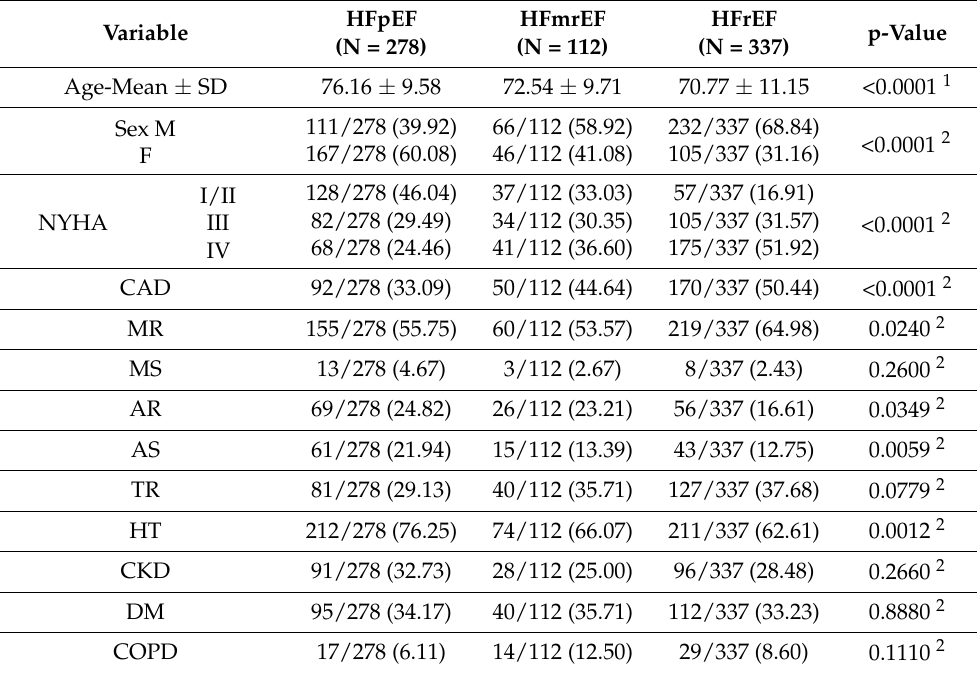
Table 1. Baseline characteristics of patients with HF and AF depending on their LVEF.